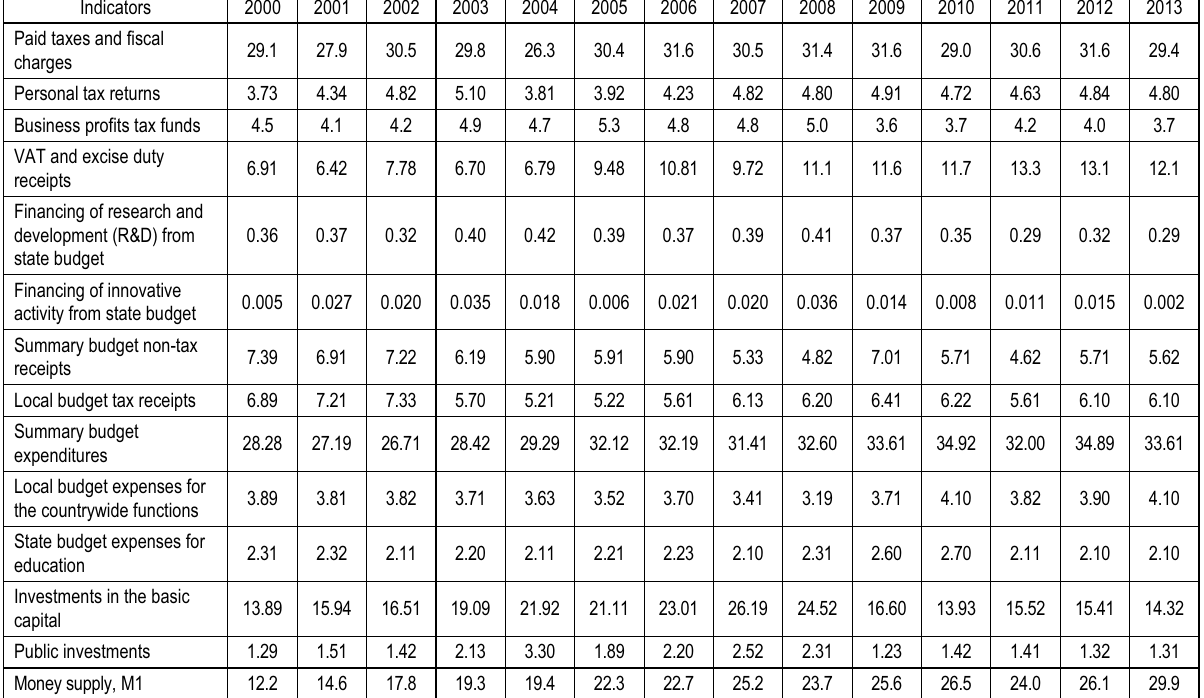
Table 1. Key indicators to the model that evaluate the innovative and scientific-technical policy of Ukraine as the means of innovative economy formation (% of